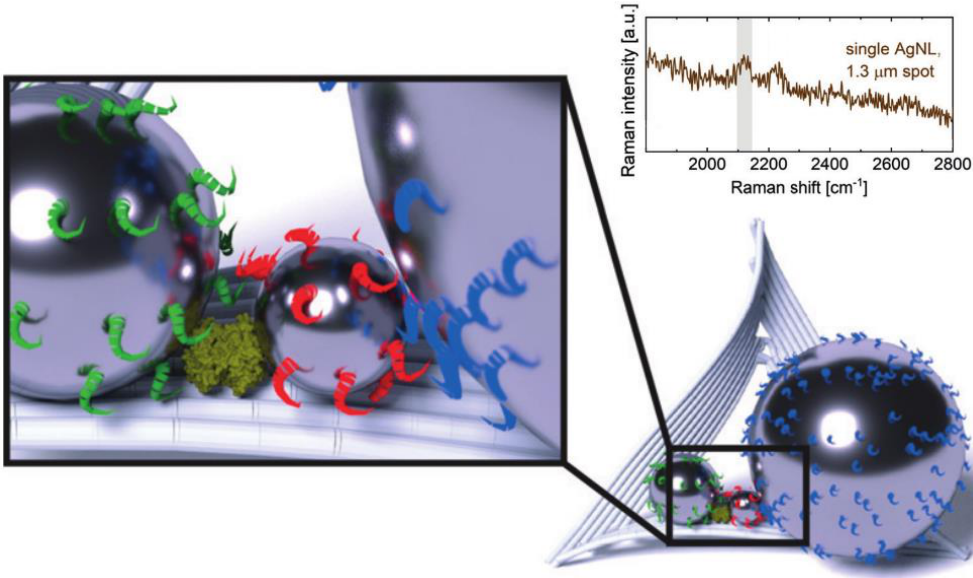
Figure 11. Silver nanolenses with a hot spot formed in the nanogap between two nanoparticles. Biotin receptor is able to bind one streptavidin molecule in the hot spot that can be detected by the specific surface-enhanced Raman scattering (SERS) signal. Adapted with permission from [322] Copyright 2018 John Wiley and Sons.